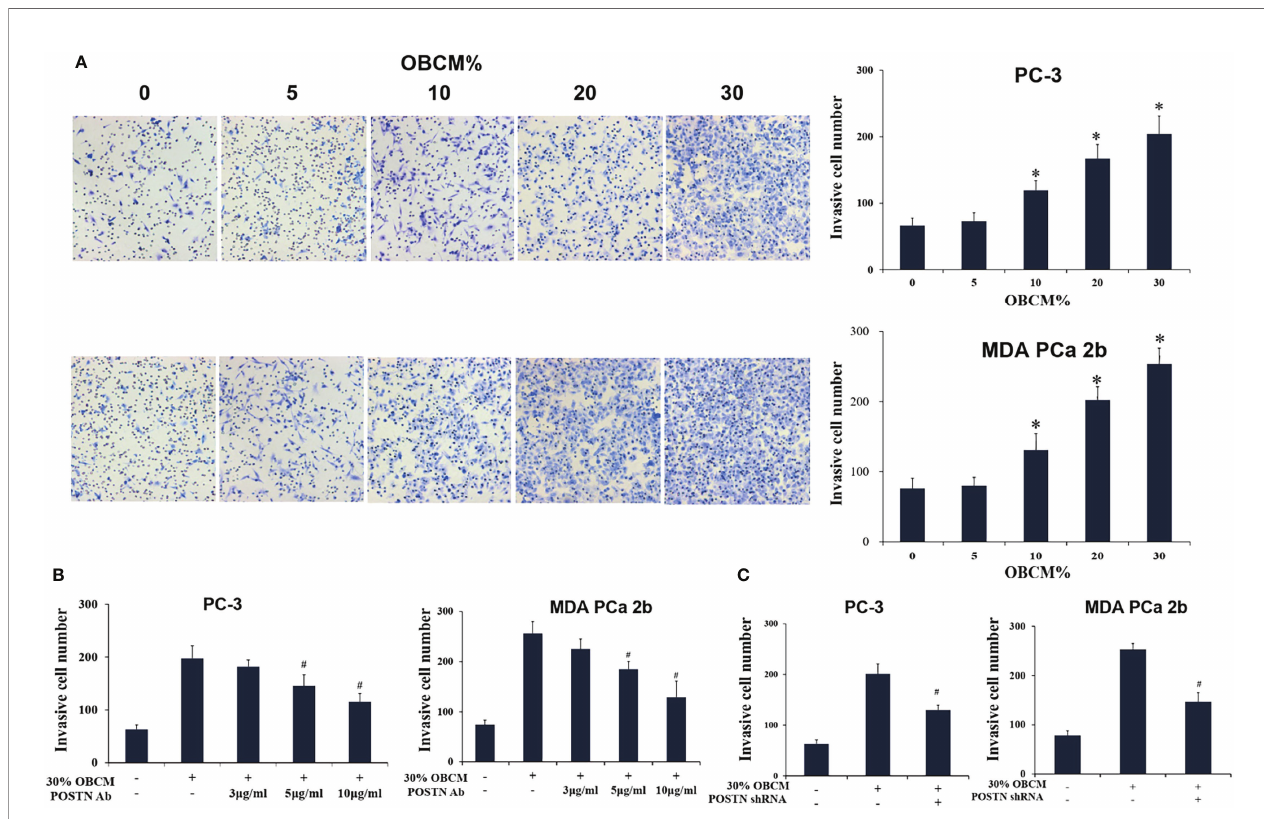
FIGURE 5 | Osteoblast-derived POSTN promotes invasion of PCa cells. (A) PC-3 and MDA PCa 2b cells were incubated with various concentrations of osteoblast (hFOB)-conditioned medium (OBCM), and cell invasion was measured by Transwell ® assays. (B) PC-3 and MDA PCa 2b cells were incubated with 30% OBCM supplemented with various concentrations of POSTN monoclonal antibody, and cell invasion was measured by Transwell ® assays. (C) PC-3 and MDA PCa 2b cells were incubated with 30% OBCM from control or POSTN-knockdown hFOB cells. Cell invasion was measured by Transwell ® assays. * p < 0.05 compared with the control; # p < 0.05 compared with the OBCM-treated